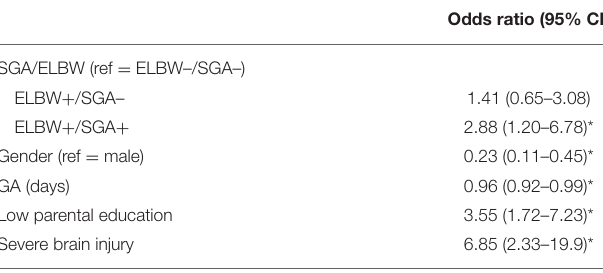
TABLE 3 | Logistic regression for attendance of special education at 8